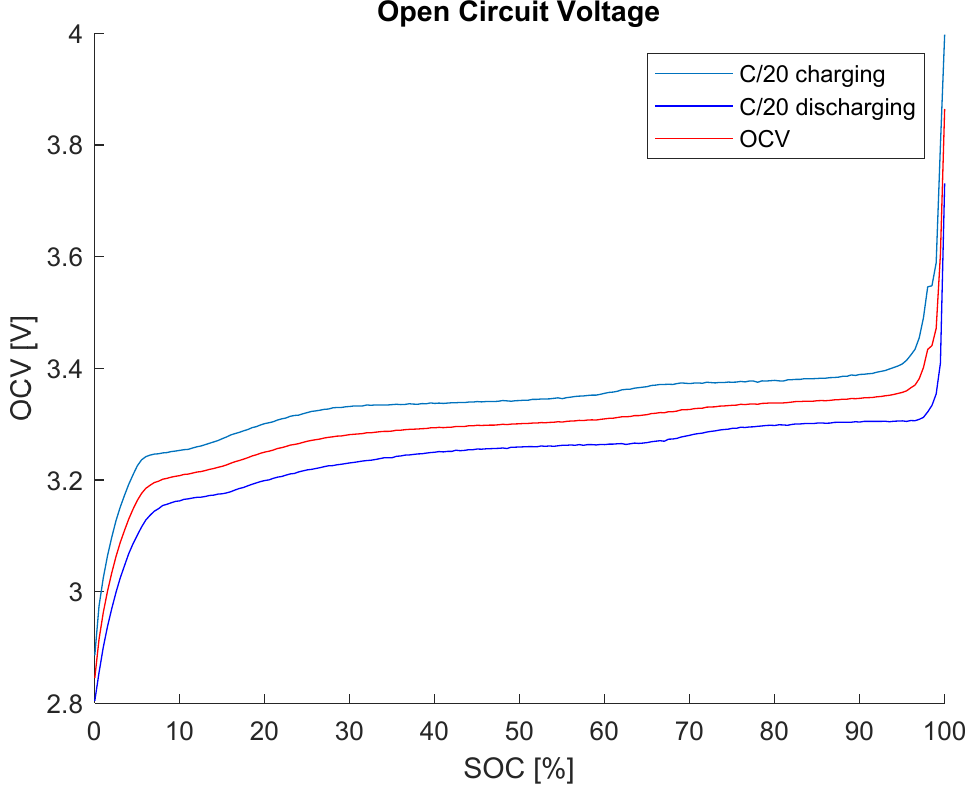
Figure 6. Lithium-ion battery OCV curve.